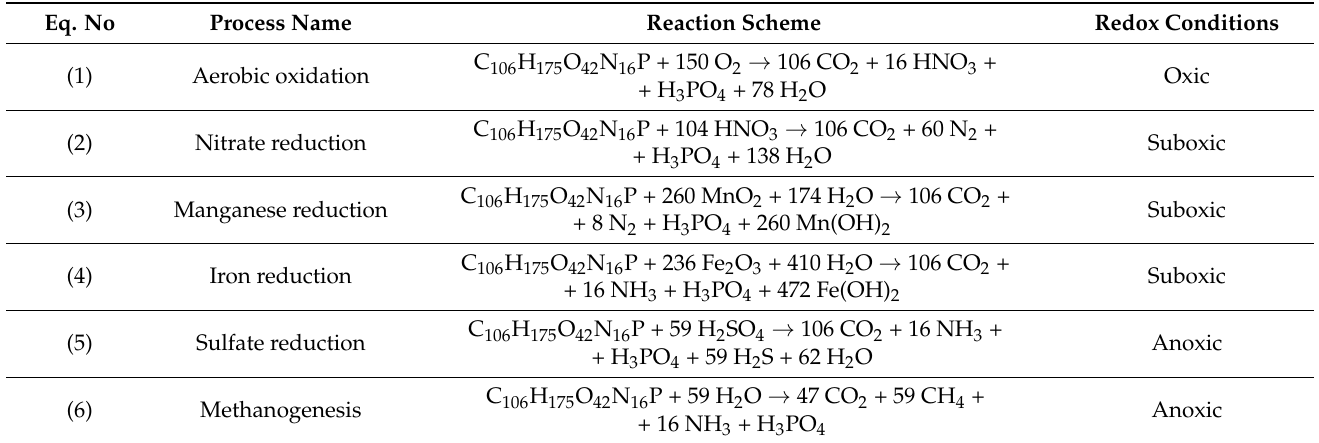
Table 1. Oxidation reactions of organic matter in bottom